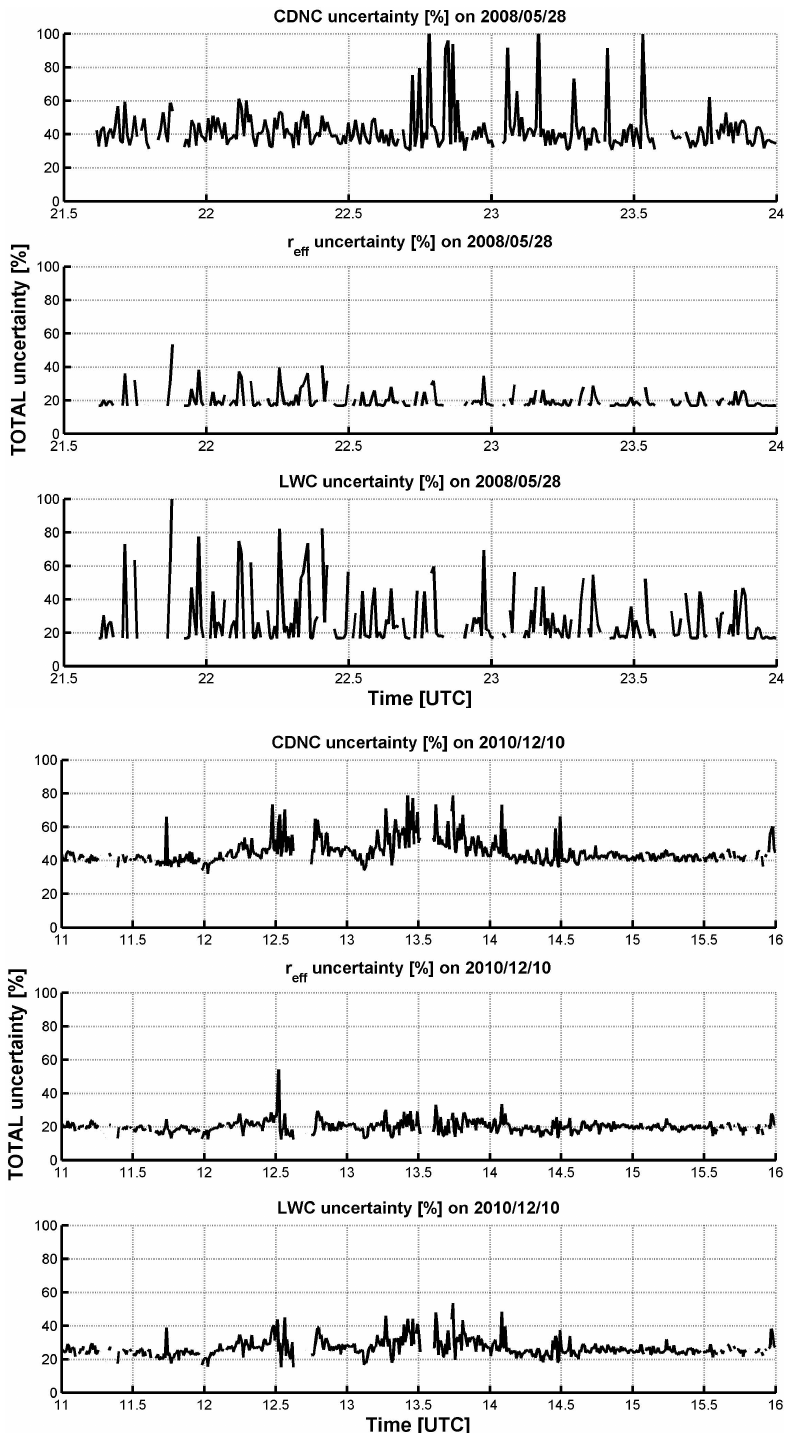
Fig. 11. Uncertainty [%] for the CDNC (upper panel), r eff (middle) and LWC (bottom) for the continental (left) and marine (right) case. Uncertainties are calculated from Eqs.